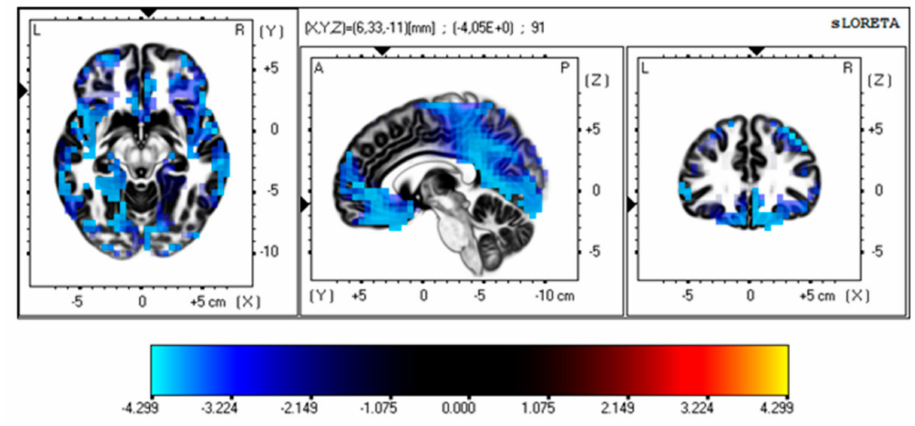
Figure 6. The sLORETA voxels expressing statistical analysis results in the control group between LEPs in the basal condition and during fast finger tapping. The maps express the maximal di ff erence in light blue, corresponding to frontal and limbic regions. For details of the analysis, see Table S1.